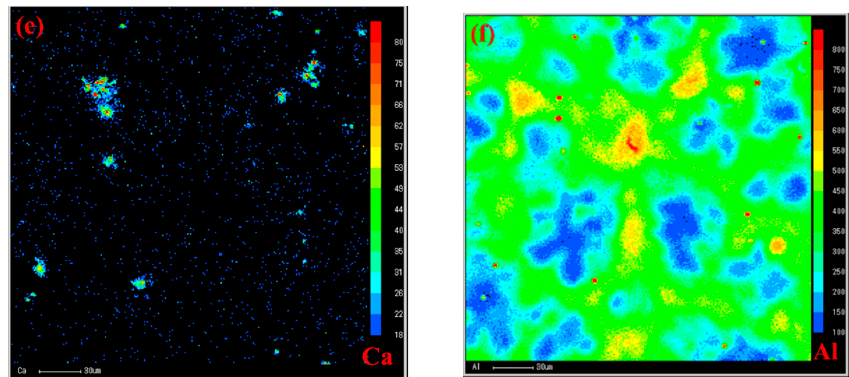
Figure 7. Electron probe microanalyzer with a wavelength dispersion spectrometer (EPMA-WDS) map analysis of Mg-3%Al-0.05%Fe refined by carbon combining with Ca inoculation, with a holding time of 80 min. ( a ) The region of EPMA-WDS map analysis; ( b – f ) the distribution of the Fe, C, O, Ca, and Al elements, respectively.